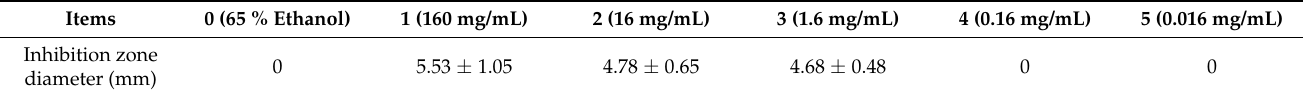
Table 4. The vitro bacteriostatic activity of AMPs.